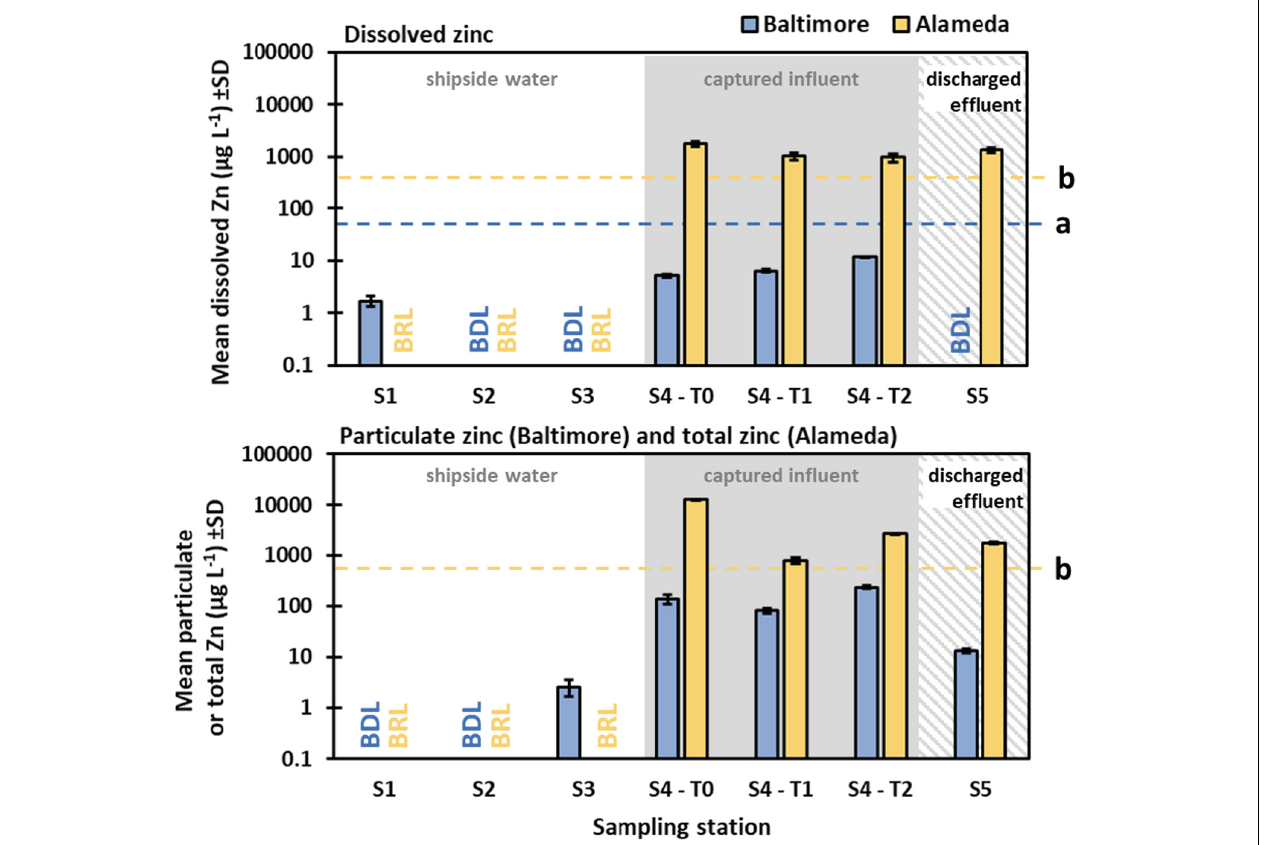
FIGURE 6 | Dissolved and particulate (Vessel 1, Baltimore) or total (Vessel 2, Alameda) zinc concentrations from water quality sampling during the Baltimore and Alameda IWCC trials. BDL (Baltimore) is below detection limits and BRL (Alameda) is below reporting limits. The blue dashed line (a) refers to the chronic dissolved standard for zinc in Maryland marine surface waters of 81 µ g/L (no standard for estuarine waters but freshwater standard is 120 µ g/L). The yellow dashed line (b) refers to the chronic total zinc standard for San Francisco Bay surface waters of 700 µ g/L (no particulate and dissolved